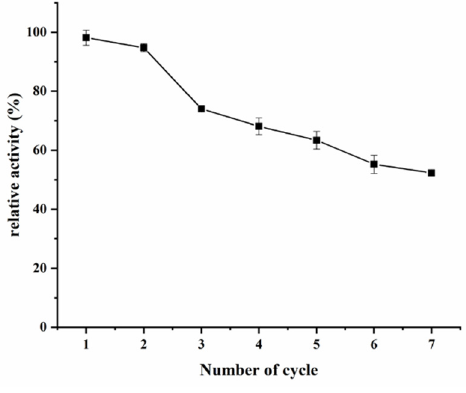
Figure 6. The reusability of XOD@PDA@HF.